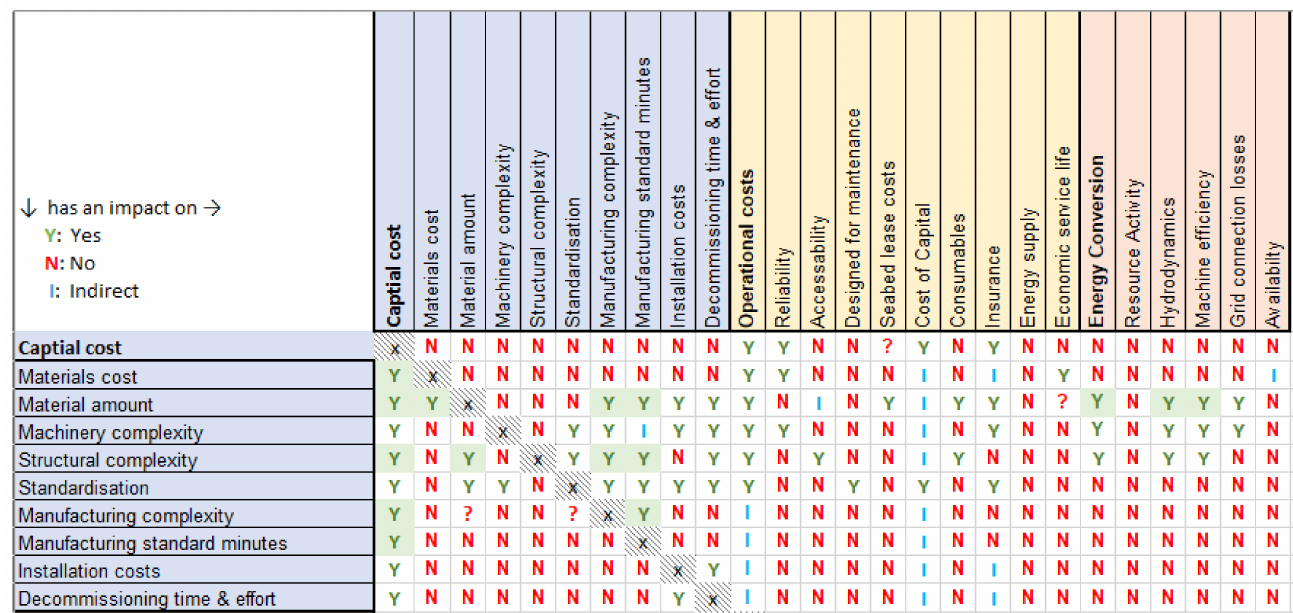
Figure 8. Example highlighting the first step of defining fundamental relationships by determining the impact of functional requirements on each other. Shaded green background indicates a fundamental relationship could be defined between